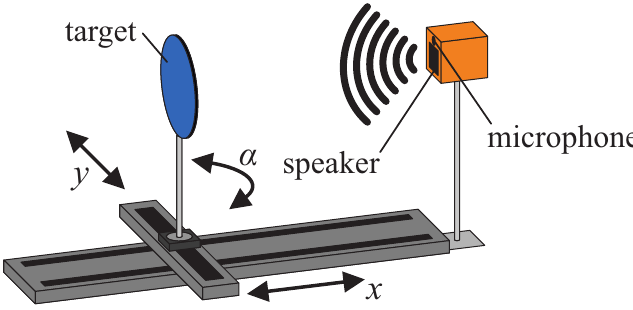
Figure 1. Measurement setup (not true to scale), with translation ( x , y ) and rotation ( α )